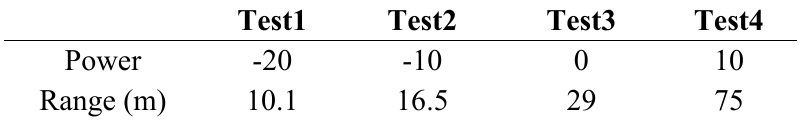
Table 3. The different transmission ranges corresponds to the transmission power.